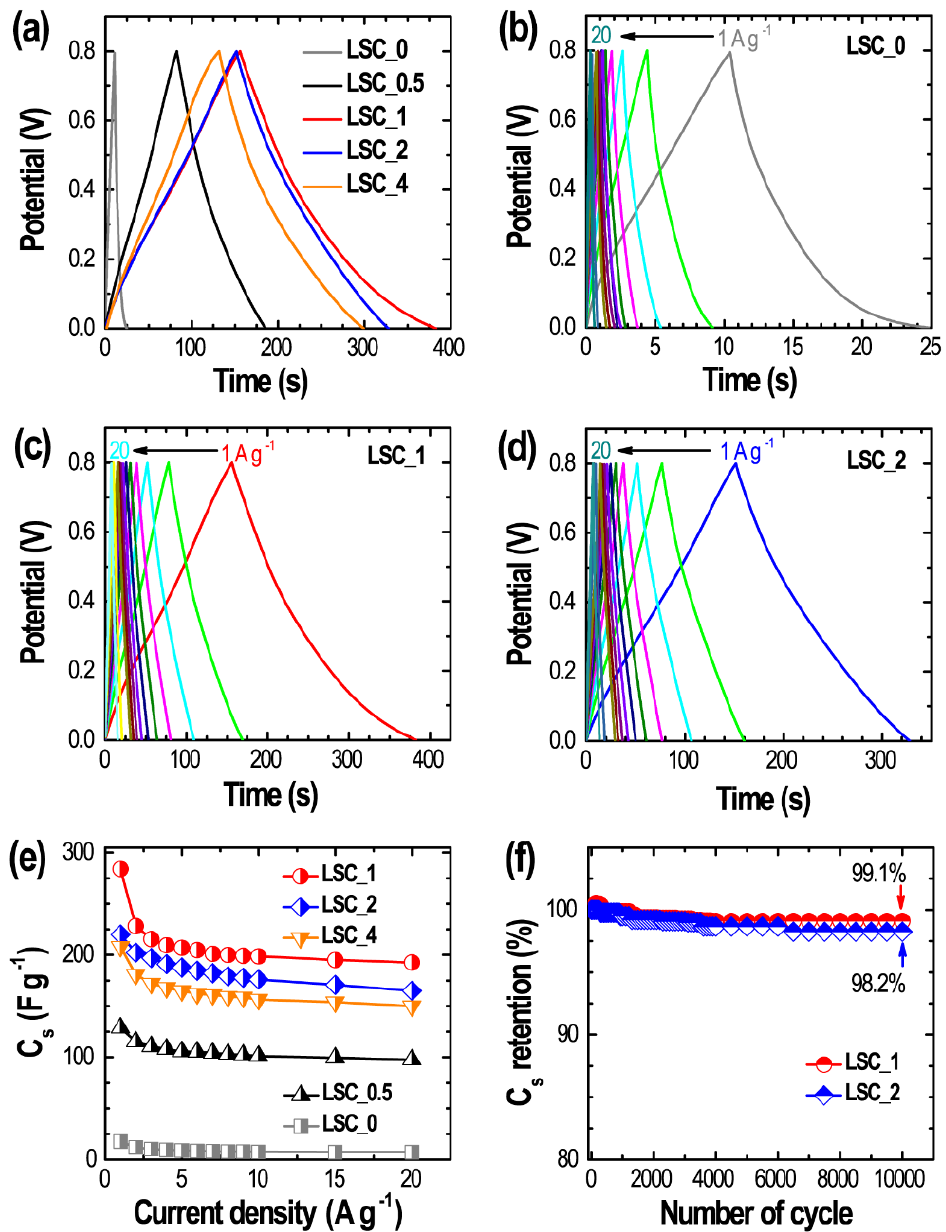
Figure 6. ( a ) Galvanostatic charge–discharge (CD) profiles of all the samples at a constant current density Figure 6. ( a ) Galvanostatic charge – discharge (CD) profiles of all the samples at a constant current of 1 A g − 1 , ( b ) CD curves of LSC_0 , ( c ) LSC_1 , and ( d ) LSC_2 at di ff erent current densities from 1 to 20 density of 1 A g −1 , ( b ) CD curves of LSC_0 , ( c ) LSC_1 , and ( d ) LSC_2 at different current densities A g − 1 as typical examples. ( e ) Specific capacitance as a function of current density for all the samples, from 1 to 20 A g −1 as typical examples. ( e ) Specific capacitance as a function of current density for all and ( f ) cycling performances of LSC_1 and LSC_2 electrodes up to 10,000 charging–discharging cycles. the samples, and ( f ) cycling performances of LSC_1 and LSC_2 electrodes up to 10,000 charging – discharging cycles. The curves show a linear region at low frequency with only weak semicircular responses at high frequency. Theweaklysemicirculartraceinthehigh-frequencyregionisanindicationofpseudocapacitance originating from the residual oxygen functional groups [63,64]. The first intersection point on the real axis is termed the equivalent series resistance (ESR) which are ca . 4.24 Ω ( LSC_0 ), 4.43 Ω ( LSC_0.5 ), 4.53 Ω ( LSC_1 ), 4.87 Ω ( LSC_2 ) and 4.77 Ω ( LSC_4 ). All the electrode materials exhibit almost similar ESR, which indicates that the di ff erence in the electrochemical performances of these materials is caused by di ff erent surface textural